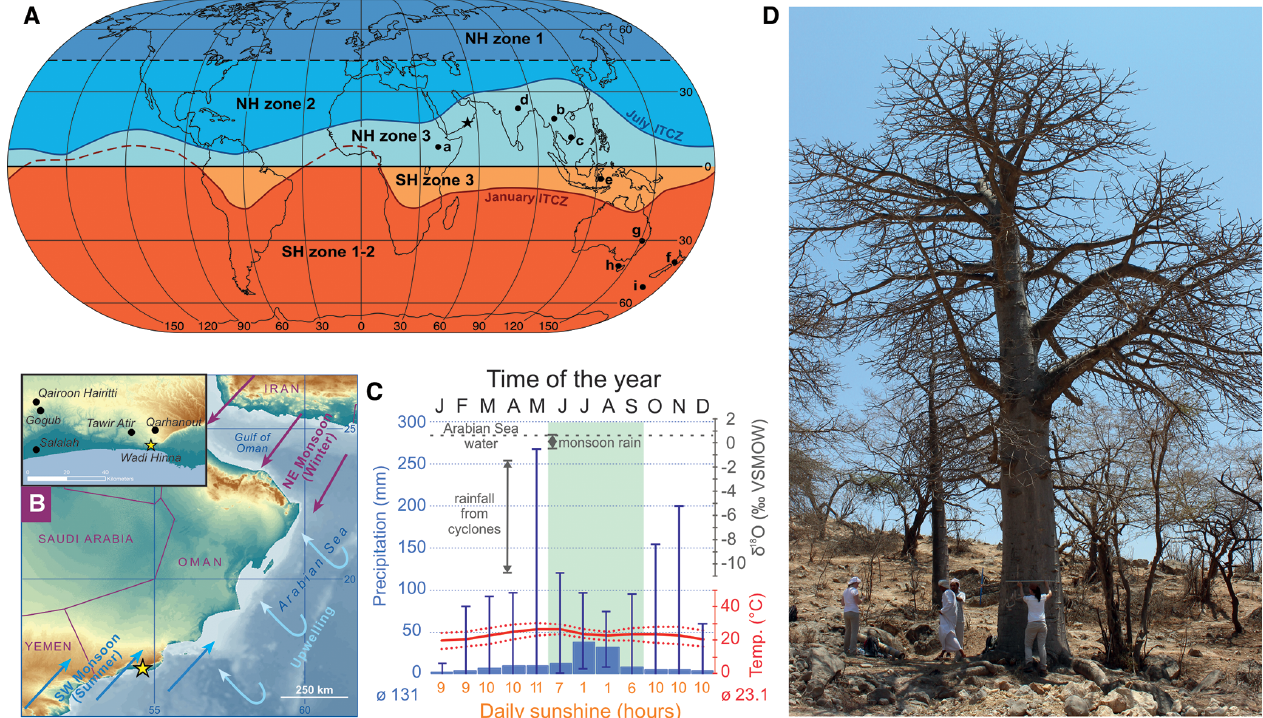
Figure 1. Context of the study site. (a) World map showing the northern hemispheric (NH) and southern hemispheric (SH) zones of atmo- spheric bomb 14 C (after Hua et al., 2013). Zones close to the Equator (NH 3 , SH 3 ) are still underrepresented in studies reconstructing the atmospheric radiocarbon indicate content. The star indicates the study site; sites labeled with letters (a)–(i) correspond to sample locations of F 14 C studies referred to in Fig. 5. (b) Map showing the location (yellow star) of the tree site Wadi Hinna (318ma.s.l.) at the edge of the Dhofar Mountains in southern Oman (17 ◦ 03 (cid:48) N, 54 ◦ 36 (cid:48) E) (map topography based on SRTM and bathymetry data from Becker et al., 2009). Prevailing seasonal wind patterns are shown by blue (summer monsoon, rainfall season) and purple arrows (winter monsoon, dry season). Light blue arrows indicate upwelling of deep waters from the Arabian Sea. (c) Climate diagram for the area around Wadi Hinna (17.0–17.5 ◦ N, 54.0–54.5 ◦ S) with average mean precipitation (bars indicating minima and maxima; source: GPCC, gpcc_V7_05) and tem- perature for 1942–2013 (dotted lines representing T min and T max , respectively; source: CRU TS4.01, GPCC V7_05). The isotopic signature of the Arabian Sea water and the precipitation around the study site is indicated in dark grey and varies significantly between monsoonal and non-monsoonal precipitation (Wushiki, 1991; Strauch et al., 2014). Average daily sunshine hours are given in orange (1979–1990, NOAA: ftp://ftp.atdd.noaa.gov/pub/GCOS/WMO-Normals/RA-II/OM/41316.TXT (last access: 25 May 2021), and the timing of the summer mon- soon and the approximate growing season of the baobab trees is indicated in green. (d) Sampled baobab tree at Wadi